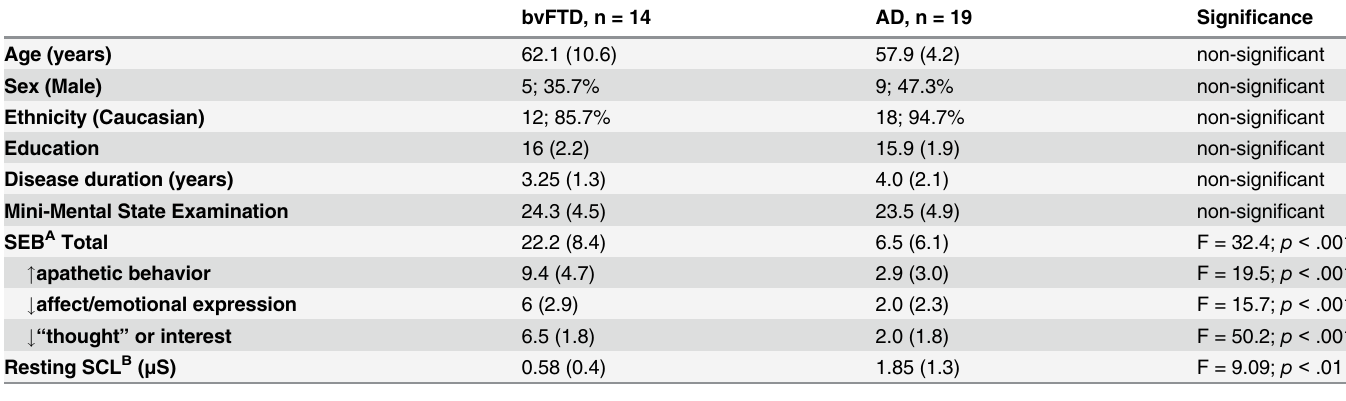
Table 2. Characteristics of the bvFTD and AD